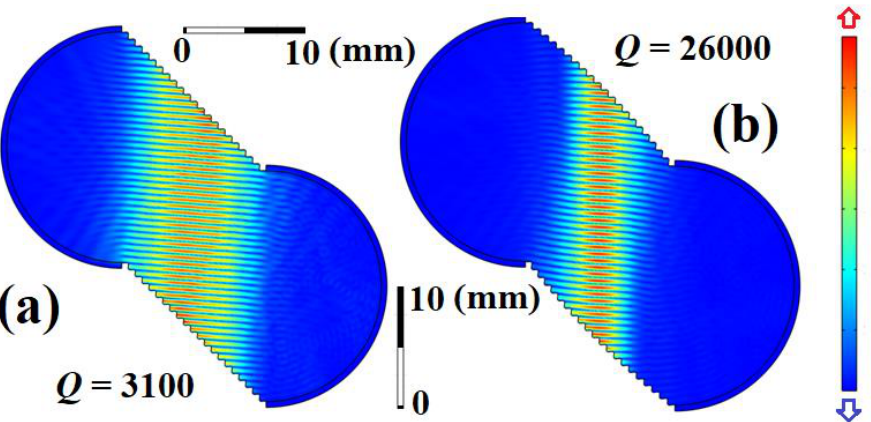
Figure 7. Transverse cross-sections of cavities with the distance between mirrors h = 20 mm. ( a ) Planar corrugated mirrors. ( b ) Optimized parabolic corrugated mirrors. Corresponding values of Q-factors of the modes are also shown.